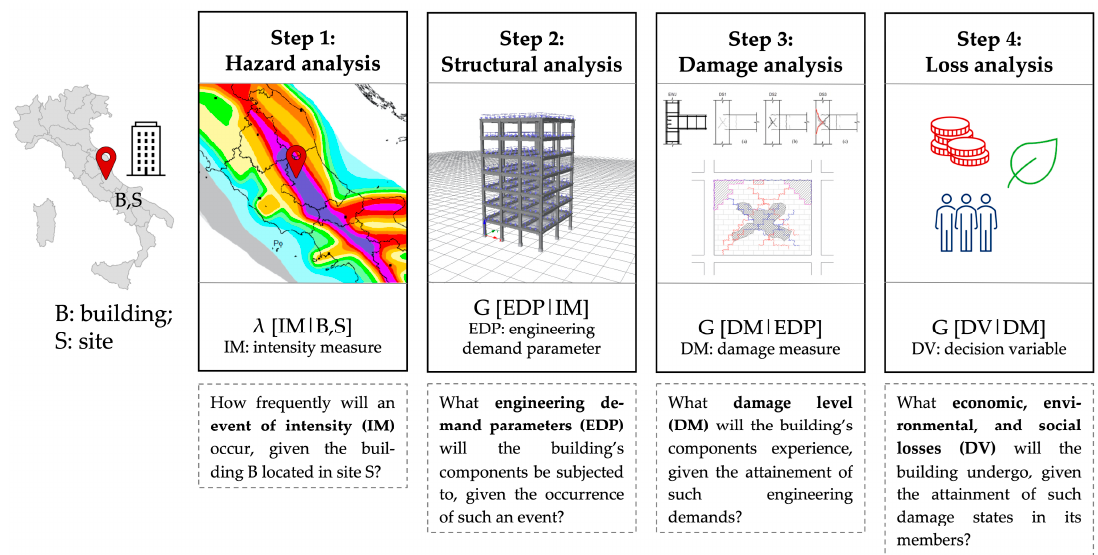
Figure 5. PEER PBEE loss assessment procedure (ATC